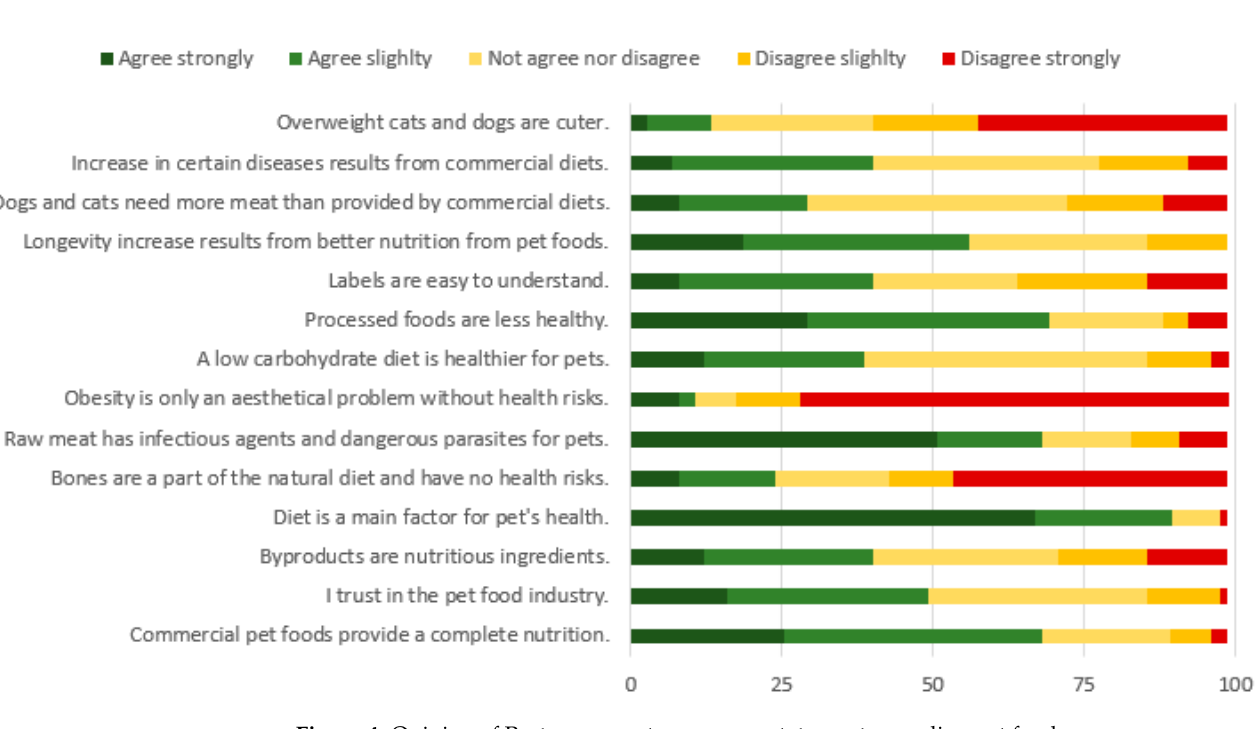
Figure 4. Opinion of Portuguese pet owners on statement regarding pet foods.